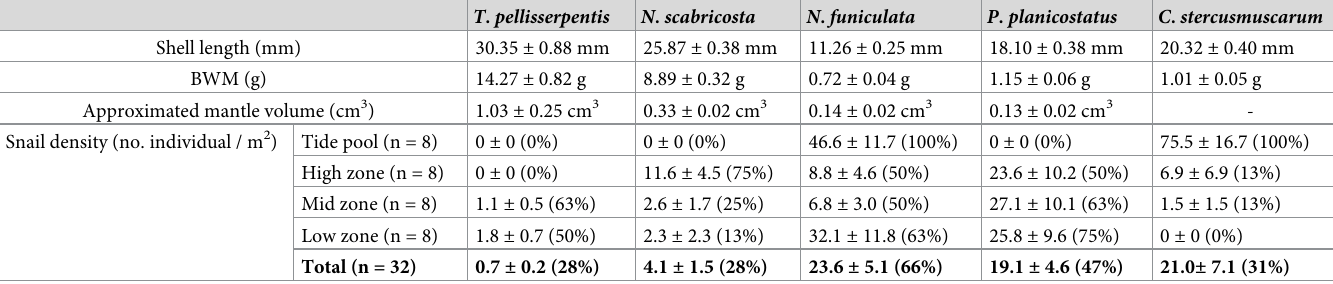
Table 1. Morphometrics, habitat, and field abundance of snail